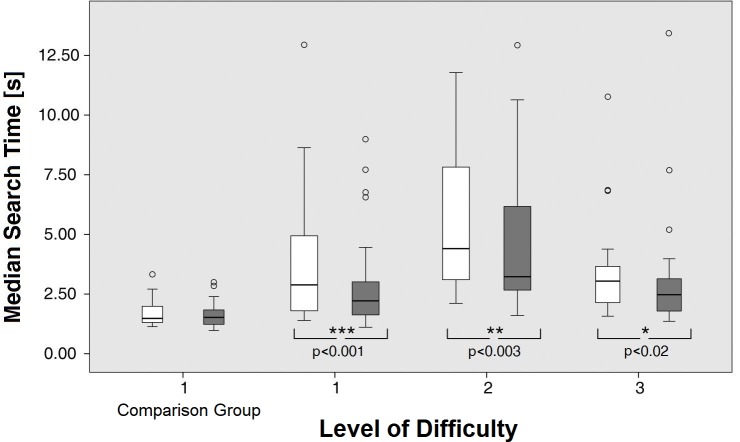
Search times during the training paradigm.In the healthy children of the comparison group, the STs were measured at T1 and T2 without training. The STs did not change by just repeating the task. The patients trained at three different levels of difficulty. The white boxplots show the STs at the beginning, the gray ones at the end of the training period of each level. The medians and IQRs indicate improvement in the patients at all three levels. Outliers were defined as values > 1.5 IQR above the 75% IQR.